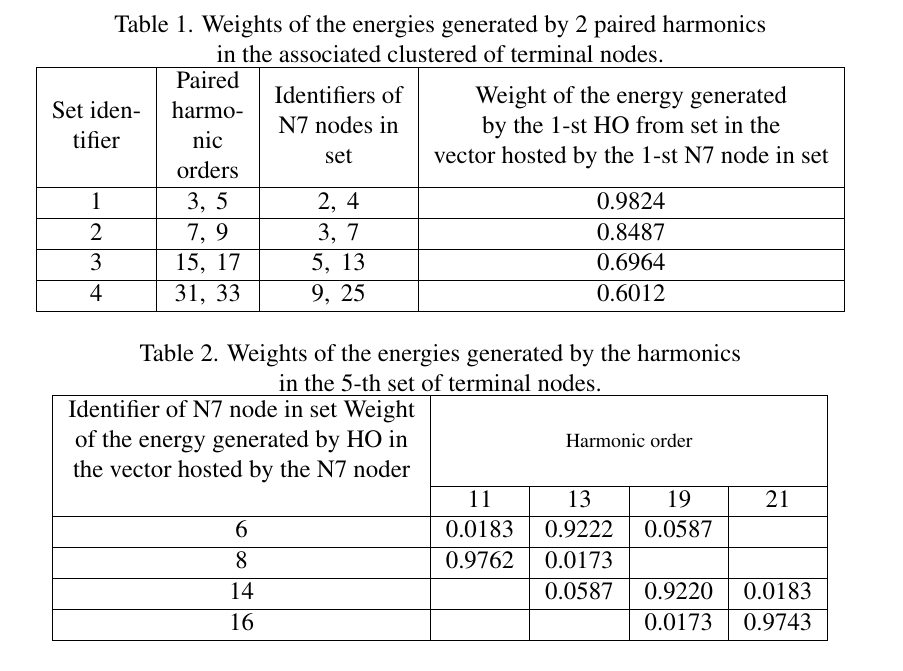
Table 3. Weights of the energies generated by the harmonics in the 6-th set of terminal nodes.